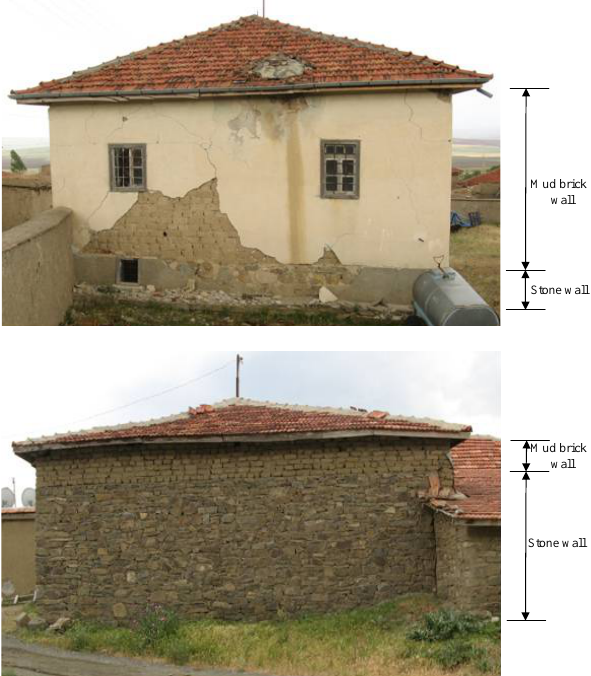
Fig. 19. Examples of damages on the stone masonry fences. Fig. 19 Examples of damages on the stone masonry fences